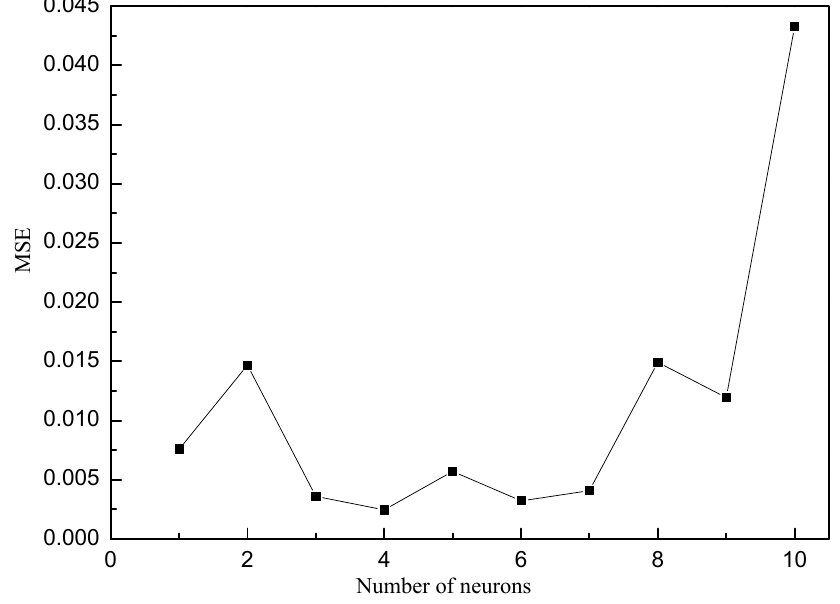
Figure 2. Effect of neuron number in the hidden layer on the performance of BP-ANN using MSE.